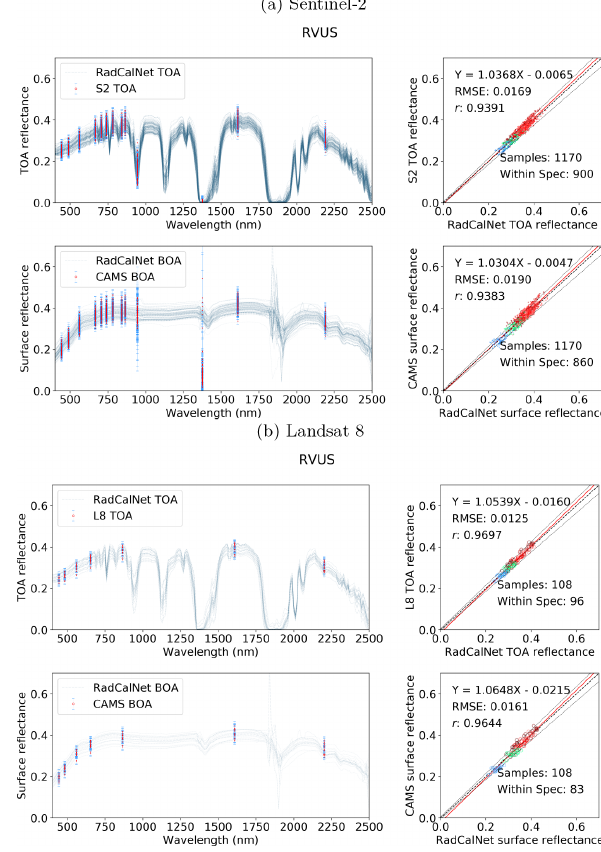
Figure I2. Same as Fig. I1 but for La Crau site. Figure I3. Same as Fig. I1 but for Railroad Valley Playa